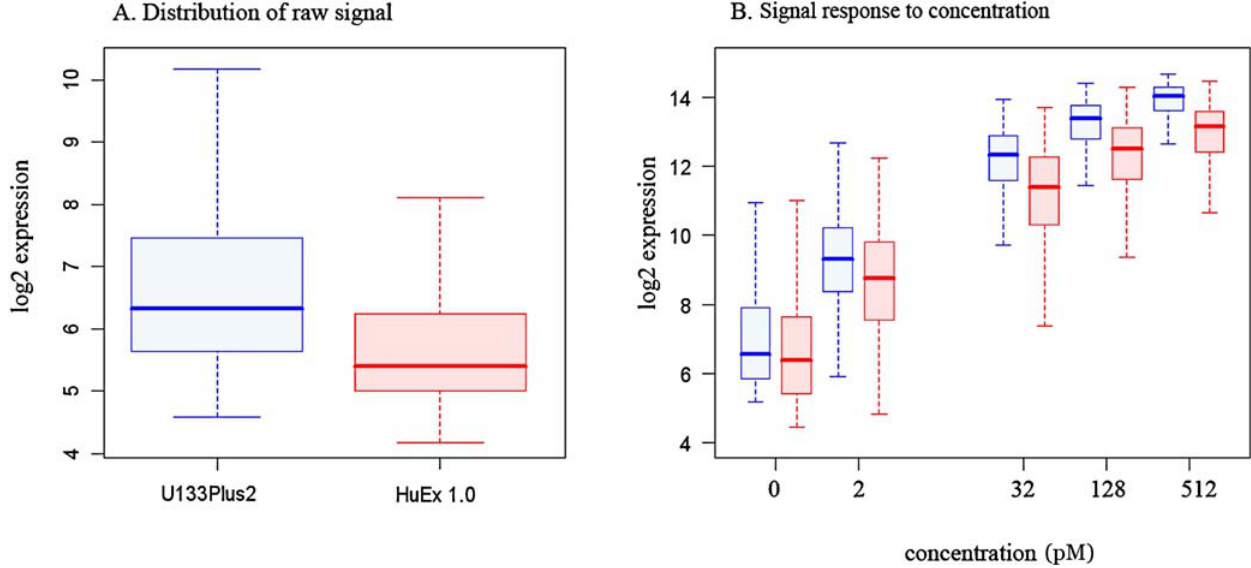
Figure 1. A) Distribution of array intensities for all probesets in HuEx 1.0 [red] and U133Plus2 [blue]. B) Signal response to spike-in concentrations in HuEx 1.0 [red] and U133Plus2